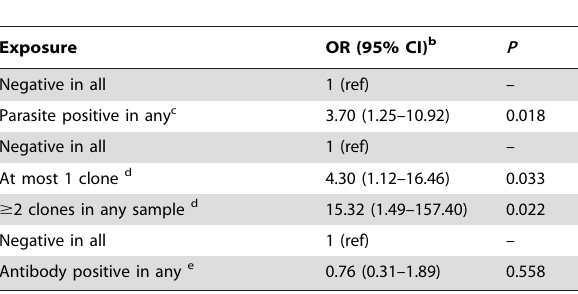
Table 2. Risk of severe malaria associated with parasite positivity, number of clones and antibodies to schizont extract in three-monthly visits before admission.